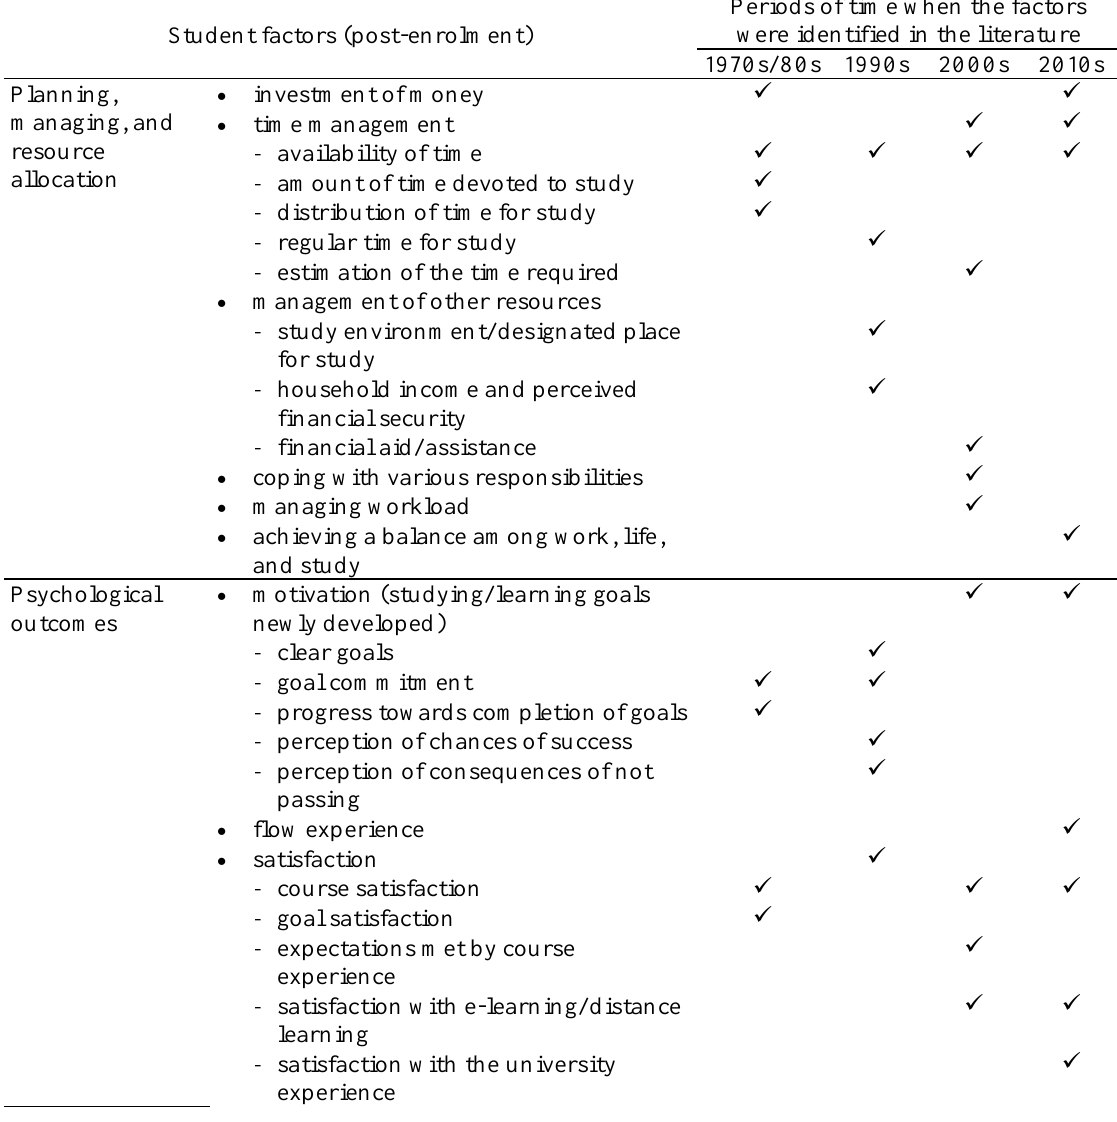
Periods of time when the factors were identified in the literature 1970s/80s